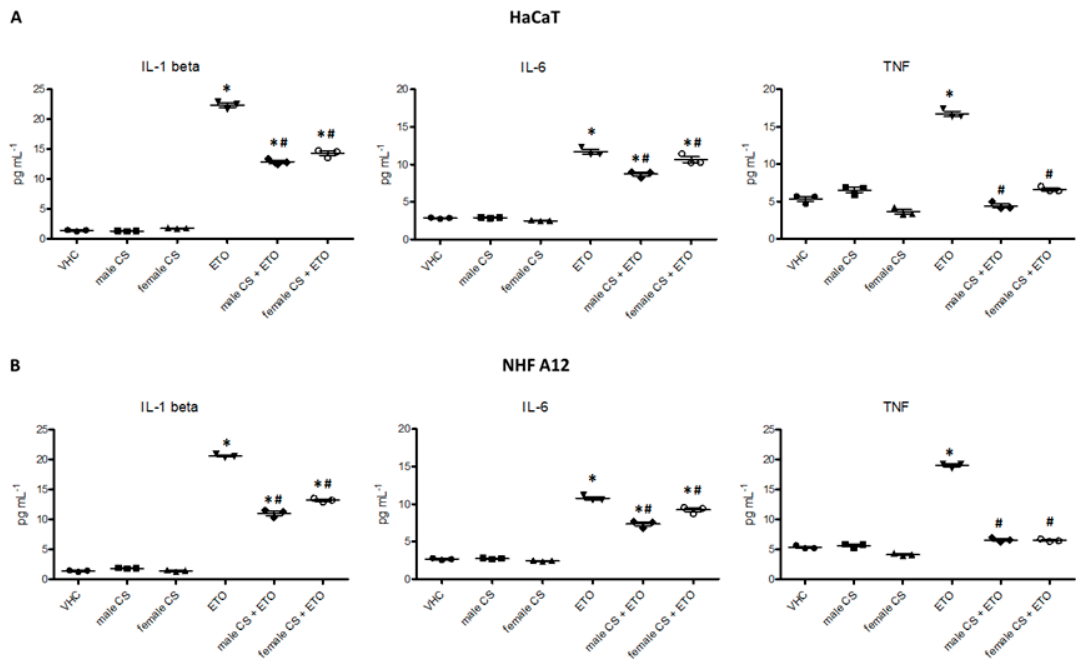
Figure 7. Hemp EOs reduced Etoposide inflammatory effect in HaCaT ( A ) and NHF A12 ( B ) cell lines. The IL-1 beta, IL-6, and TNF protein levels were quantified in culture medium. Amounts of cytokines were reported as pg/mL. * p < 0.05 vs vehicle, # p < 0.05 vs ETO.